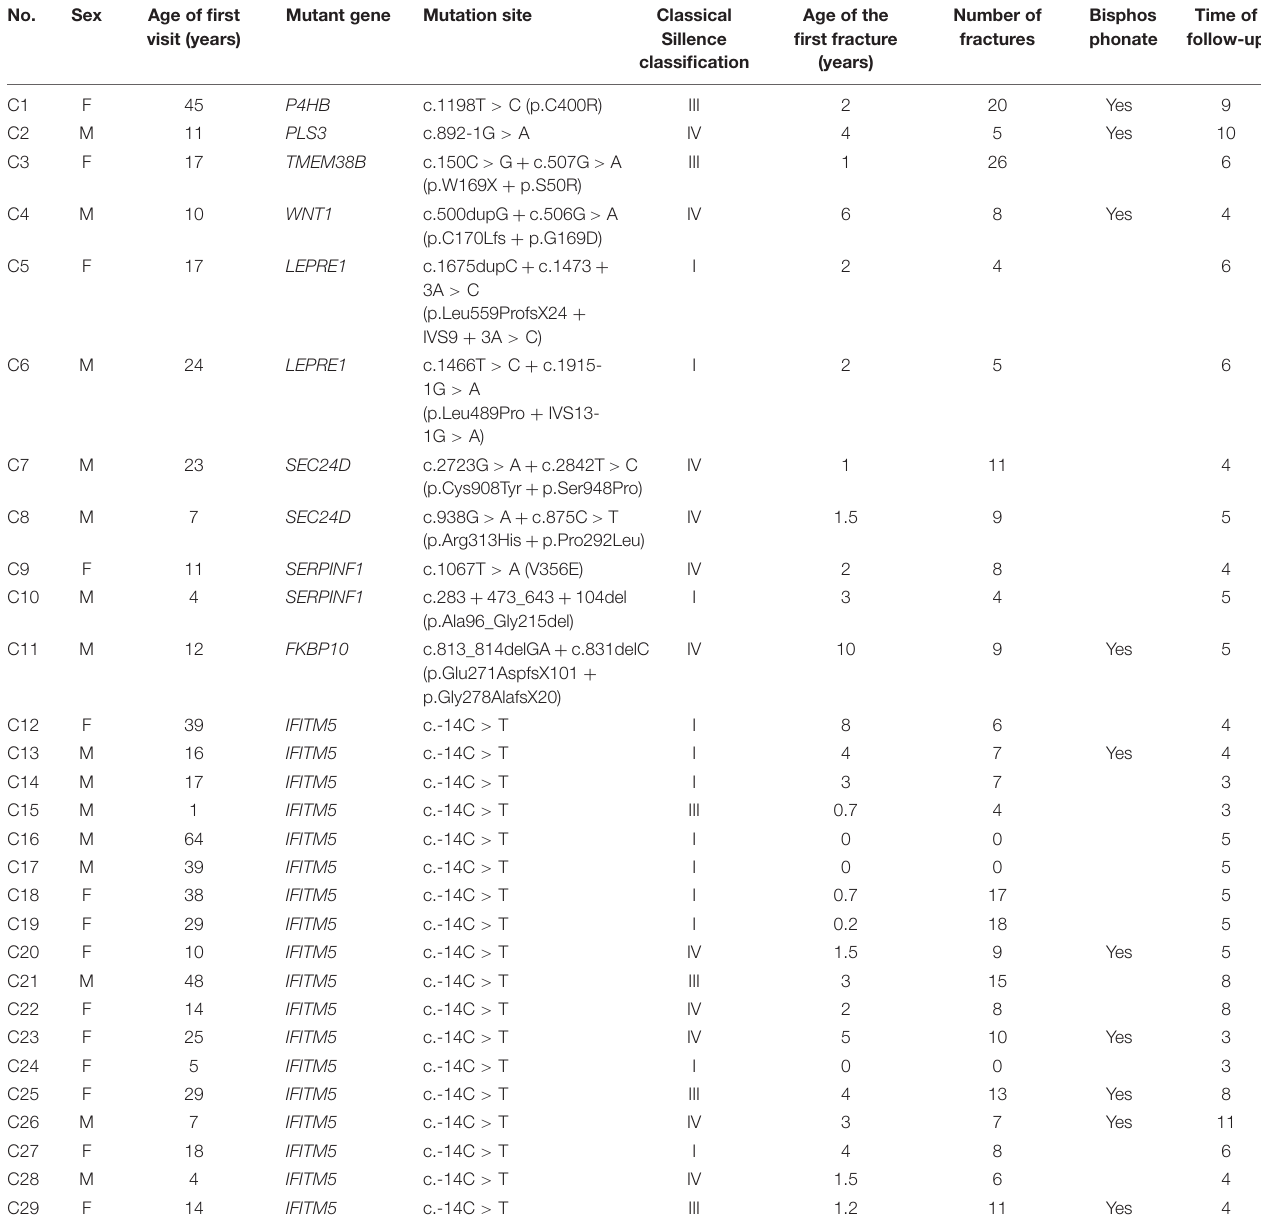
TABLE 1 | Demographic features and fracture incidence of rare types OI